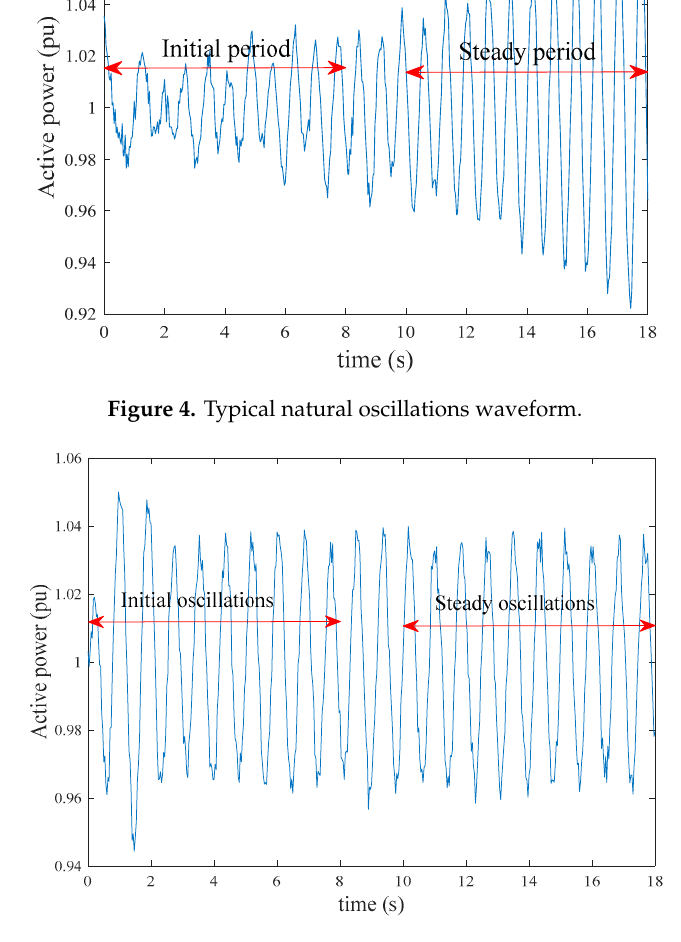
Figure 5. Typical forced oscillations waveform. Table 6. Model identification accuracy